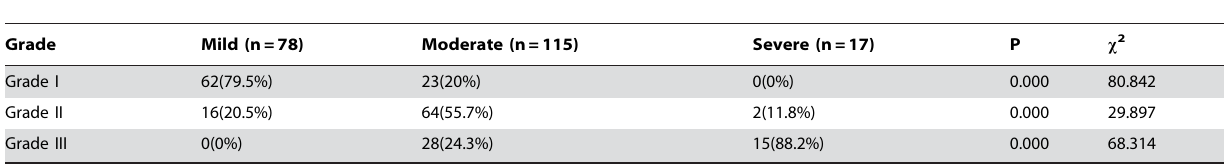
Table 2. Transverse-mesocolon involvement and MRSI in patients with AP.